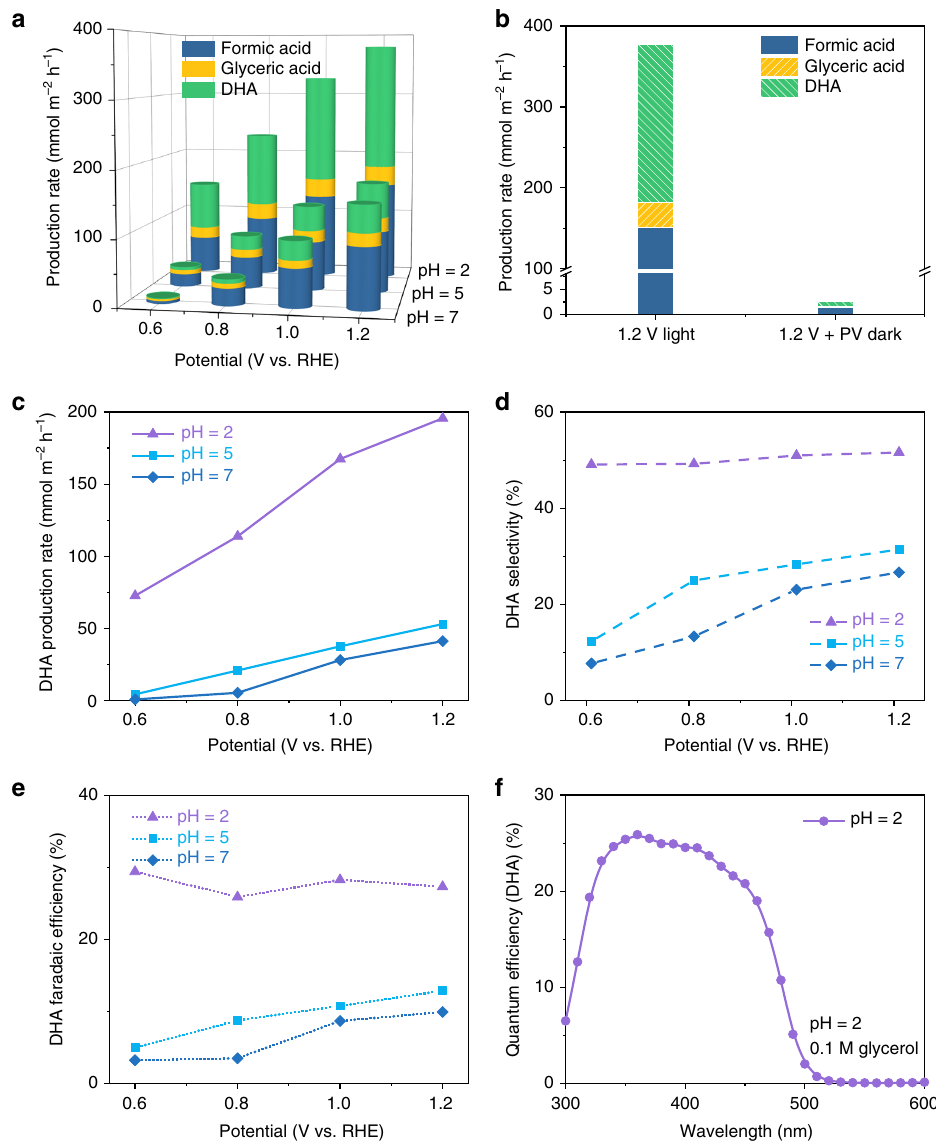
Fig. 4 Selective photoelectrochemical oxidation of glycerol. a Photoelectrocatalytic production rate of oxidation products on BiVO 4 photoanode at reaction pH of 2, 5, and 7, respectively in 1 h. b Production rate of oxidation products at pH = 2 and 1.2 V vs. RHE under illumination or 1.375 V vs. RHE in dark, respectively c – e Production rate, selectivity, and faradaic ef fi ciency of DHA produced in an H-type cell at pH = 2, 5, and 7. f Incident photon-to-DHA conversion ef fi ciency spectrum acquired at pH = 2 and 1.23 V vs.